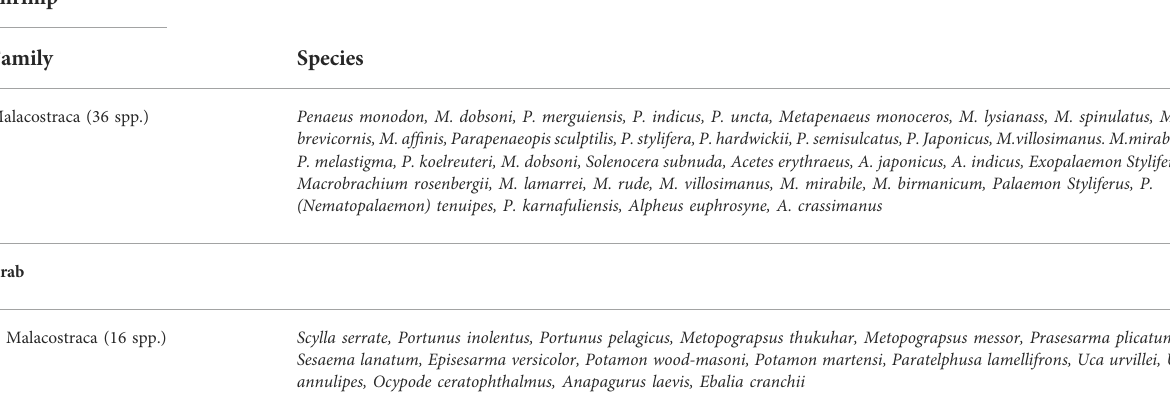
Malacostraca (16